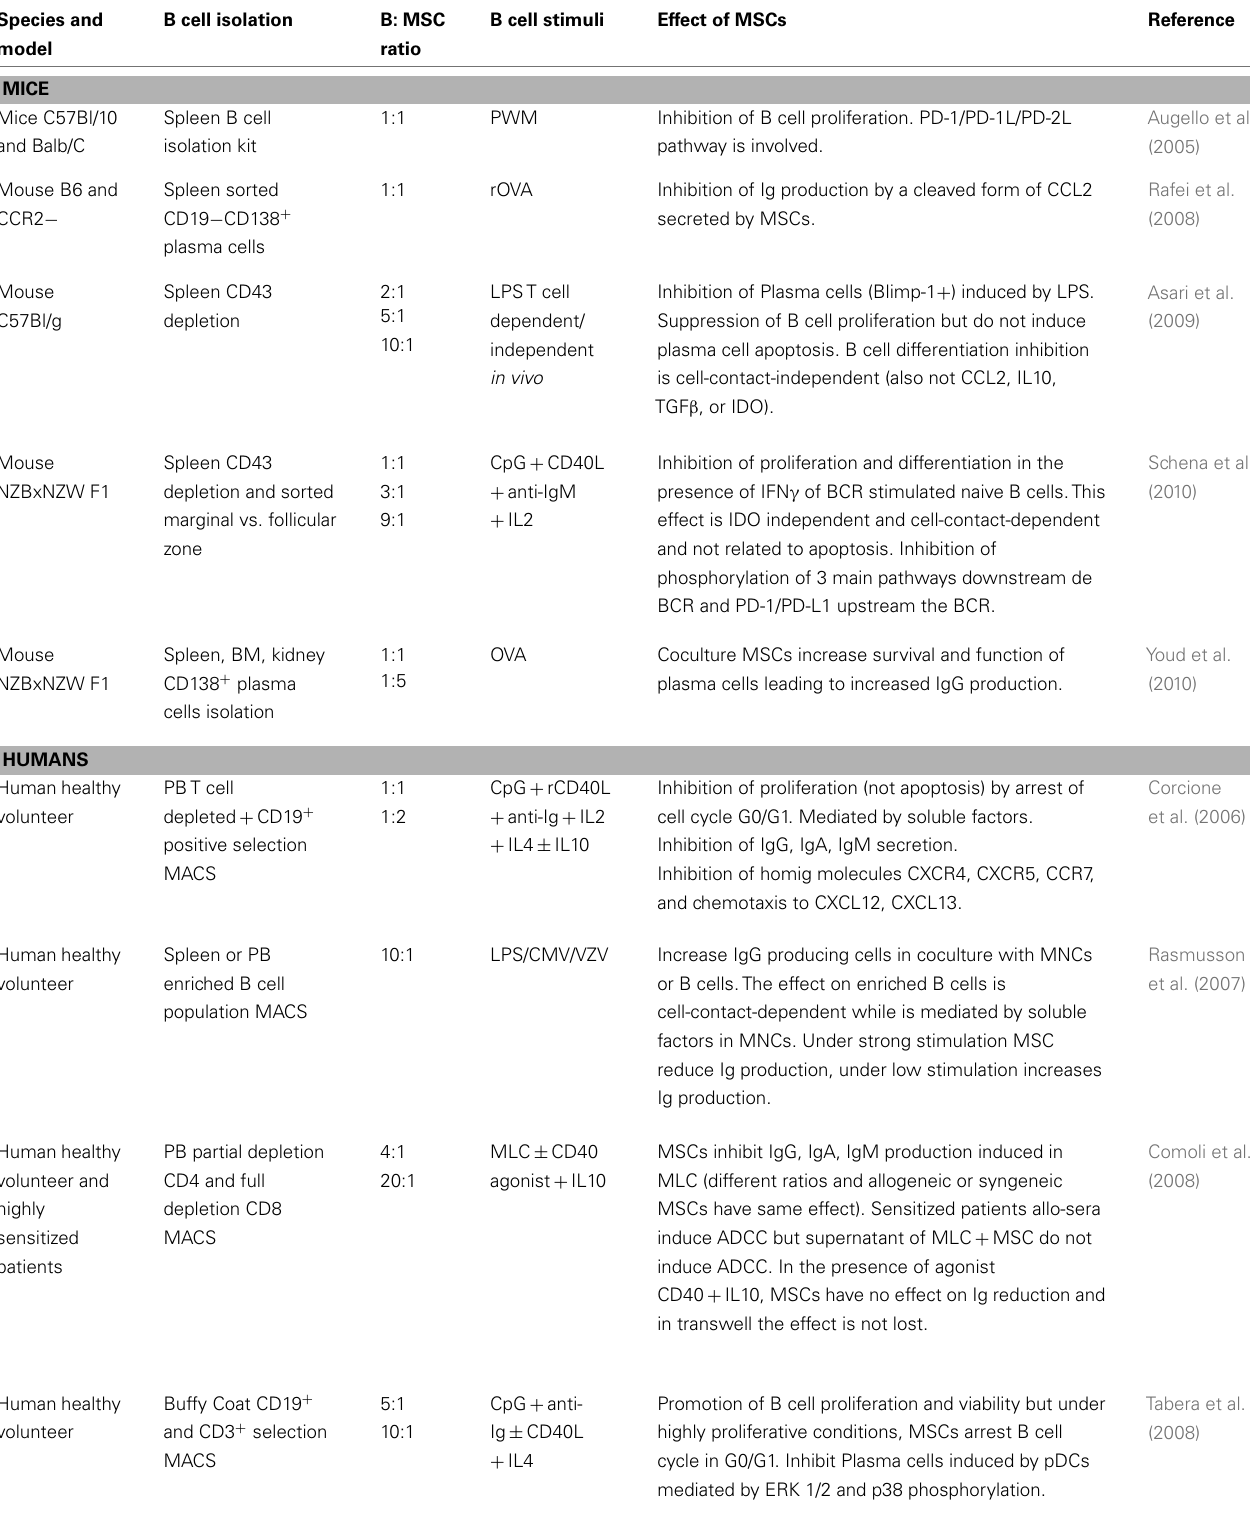
Table 1 | Effect of MSCs on B cells in vitro